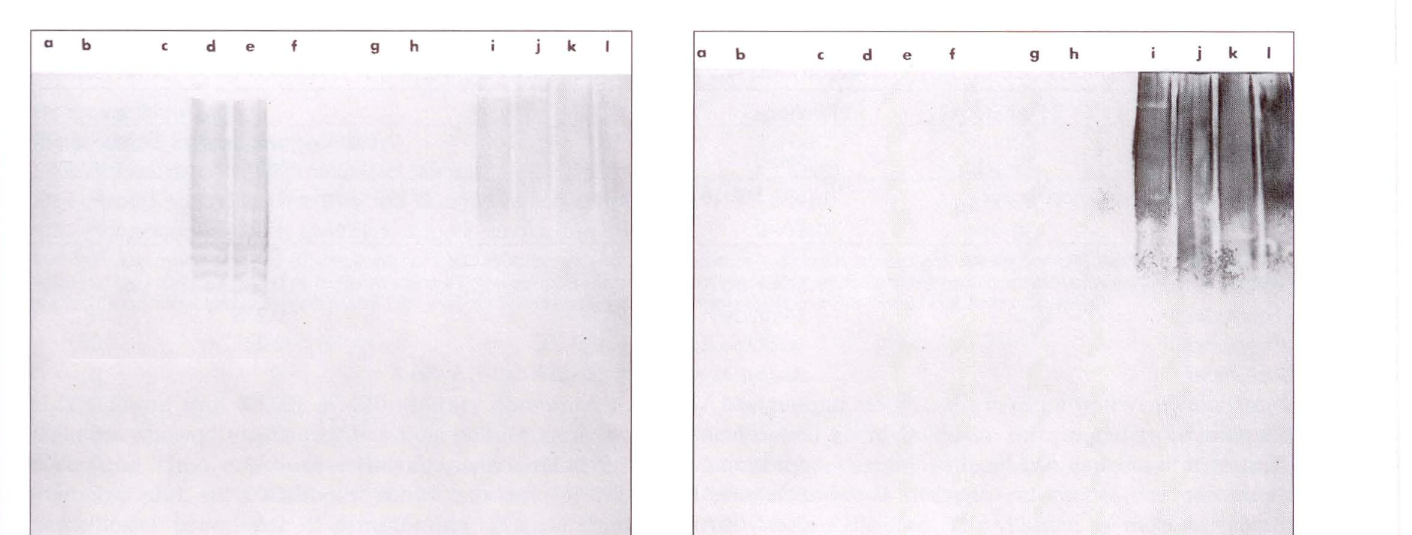
Figure 3) Reaction of whole cell lipopolysaccharide of selected bacteria and antipolysaccharide serum {left) or monoclonal antibody (right) as shown by immunoblot reaction. Lanes are: a: Pseudomonas cepacia serotype B: b: Pseudomonas aeruginosa